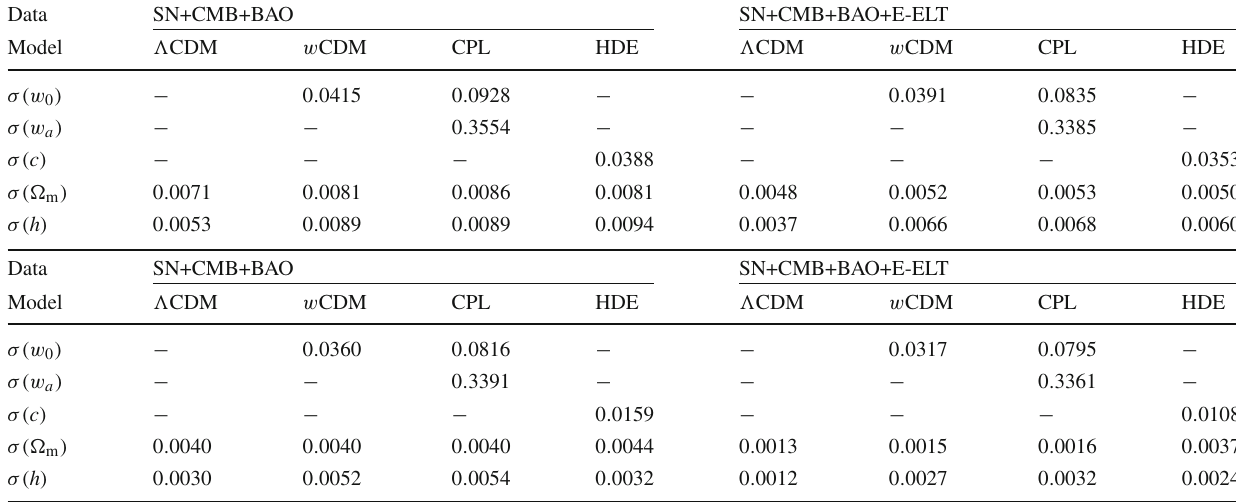
Table 4 Constraint errors of parameters in the (cid:2) CDM, w CDM, CPL, and HDE models using SN+CMB+BAO,